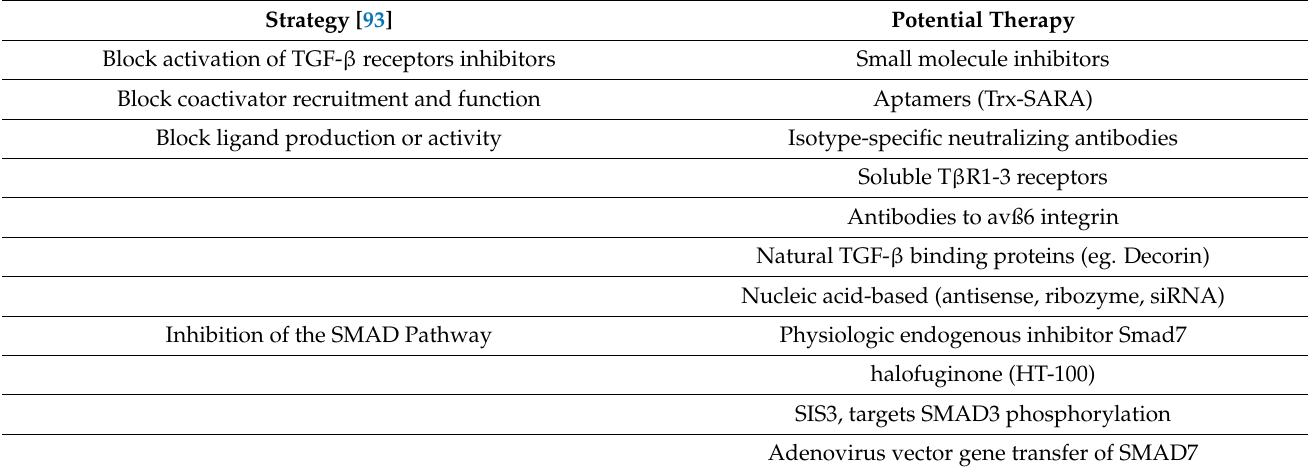
Figure 2. Schematic illustration of canonical and non-canonical TGF- β signalling pathways. Canonical SMAD-dependent TGF- β signalling is initiated by TGF- β ligand binding to receptors TGFBRI/RII, which once activated, lead to the phosphorylation and activation of SMAD2/3 which, in turn, binds to cofactor SMAD4. The trimeric SMAD complex translocate into the nucleus, where they interact with other transcription factors to regulate target gene expression. In the SMAD-independent pathways, the TGF- β receptor complex transmits its signal through other factors, such as RAS-RAF-MEK-ERK. Once activated, ERK1 and ERK2 can facilitate EMT by increasing the expression of EMT transcription factors. Moreover, activated TAK1/JNK/JUN factors act to regulate cellular apoptosis and proliferation, whereas they can also mediate metastasis, angiogenesis and cellular growth through other transcription factors. Table 1. Potential therapy interfering with TGF- β dependent